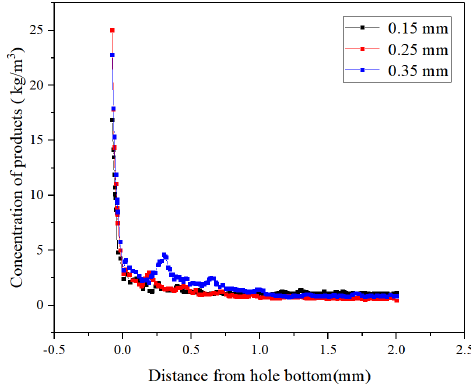
Figure 9. Concentration distributions of the processed products in the axial direction of the hole in the side machining gaps using trapezoidal helical electrodes with different pitches.